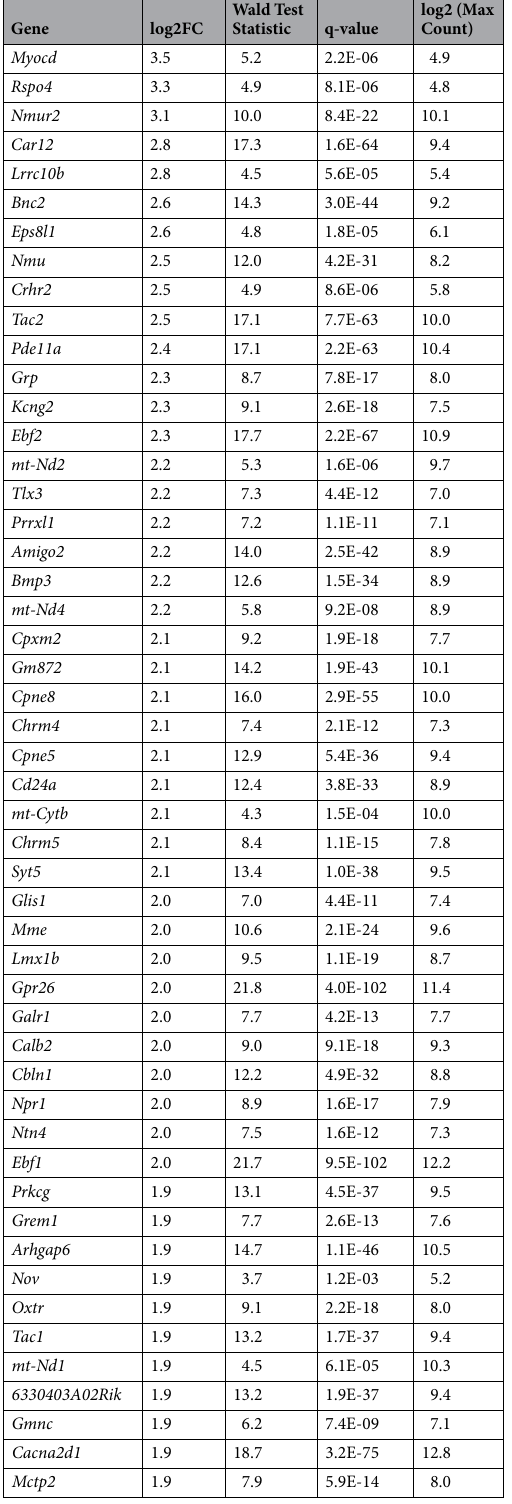
Table 1. Top 50 differentially expressed genes in SST neurons compared to total dorsal horn cells. For each gene we report: gene, log2(fold change), Wald Test Statistic, q-value (adjusted p-value) and the log2(Max Count), which is log base-2 of the maximum normalized count value for each gene. n =